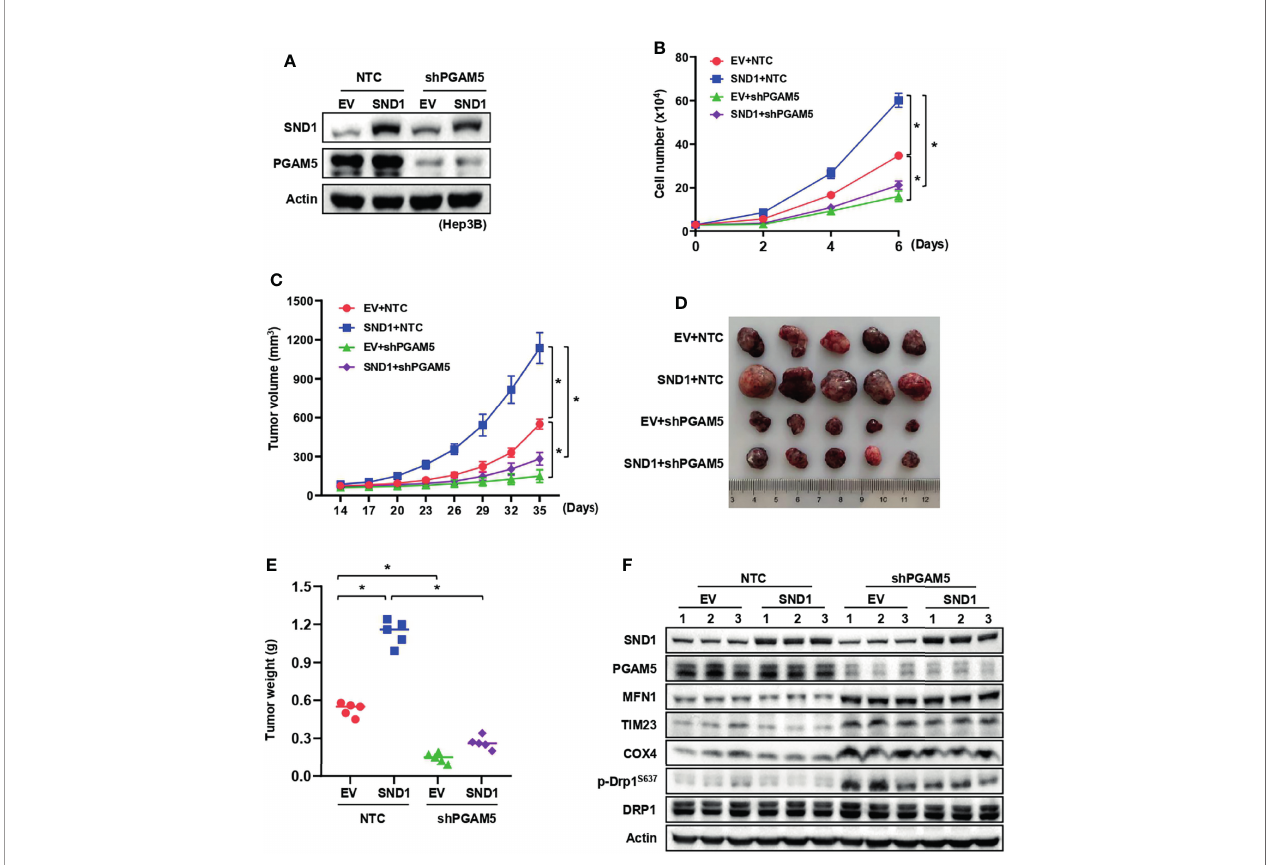
FIGURE 6 | The promotion effect of SND1 on cell proliferation and tumor growth depends on PGAM5. (A, B) Growth curves were measured in SND1- overexpressing Hep3B cells expressing shRNA against PGAM5. Data are presented as the mean ± SD of three independent experiments. * P < 0.05 comparing the indicated samples. (C – E) Equal numbers of Hep3B cells mentioned in panel (A) were injected subcutaneously into the fl anks of BALB/c nude mice (n = 5 mice in each group). Tumor sizes were measured every 3 days using calipers (C) . Photographs show xenografts (D) , and tumor weights (E) were determined at the end of the experiment (Day 35). Data are presented as the mean ± SD, * P < 0.05 comparing the indicated groups. (F) Protein levels of SND1, PGAM5, MFN1, TIM23, COX4, p-DRP1 S637 , and DRP1 in tumor lysates of panel D were measured by immunoblotting analysis. Actin served as loading